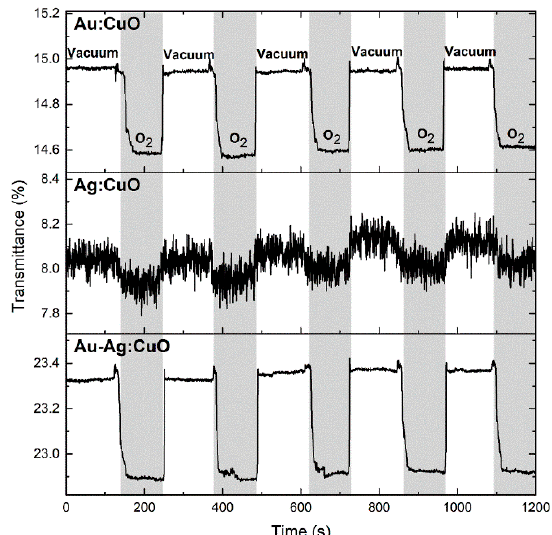
Figure 8. Variation of the LSPR peak position (transmittance minimum) of the Au:CuO, Ag:CuO, and Au-Ag:CuO films over time for five cycles of vacuum and O 2 atmosphere.